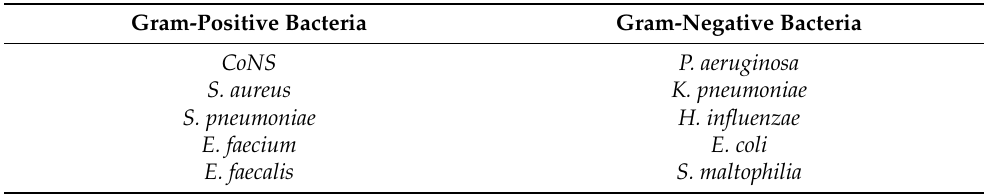
Table 5. Most common co-infections detected in COVID-19 patients caused by Gram-positive or Gram-negative